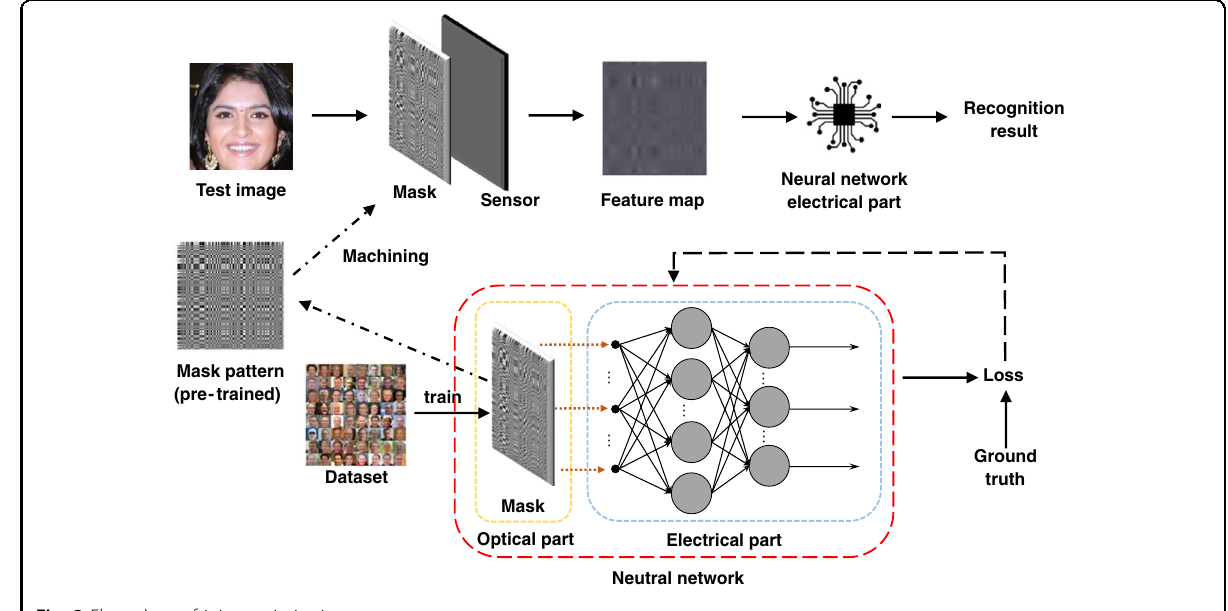
Fig. 3 Flow chart of joint optimization